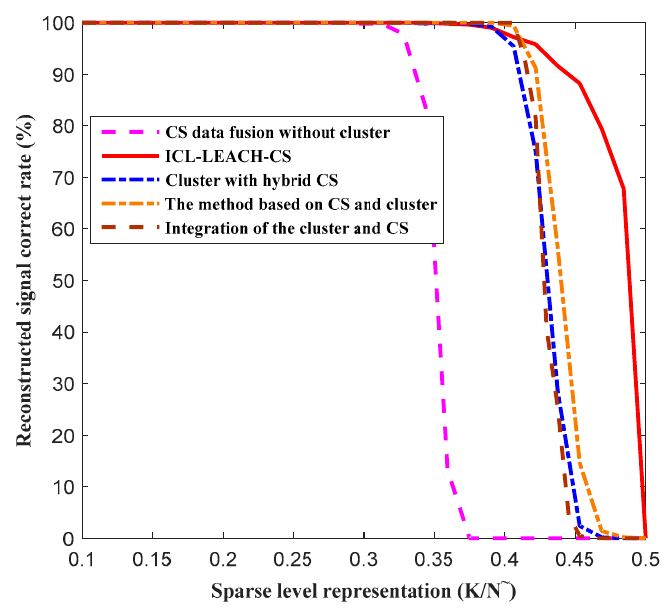
Figure 17. Reconstructed signal correct rate vs. the sparse level representation.